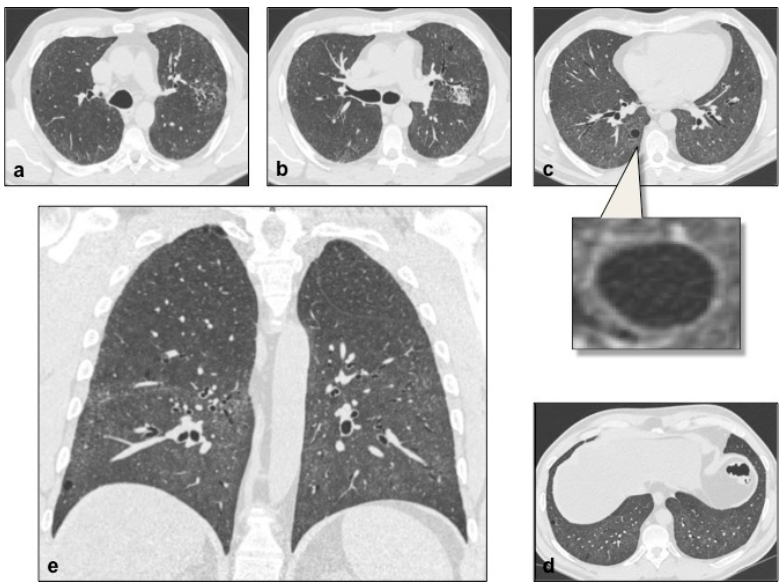
Figure 11. DIP cysts, mostly located in subpleural regions ( a , b , c , d ). Multiplanar reconstruction (MPR) in the coronal plane ( e ). This figure has been partially modified from ECR 2017 / C-2141 Cystic pattern in lung diseases: a simplified HRCT guide based on free-hand drawings, DC Caltabiano, V. Costanzo, L. Mammino, V. Vindigni, S. Torrisi, R. Rosso, LA Mauro, C. Vancheri, S.